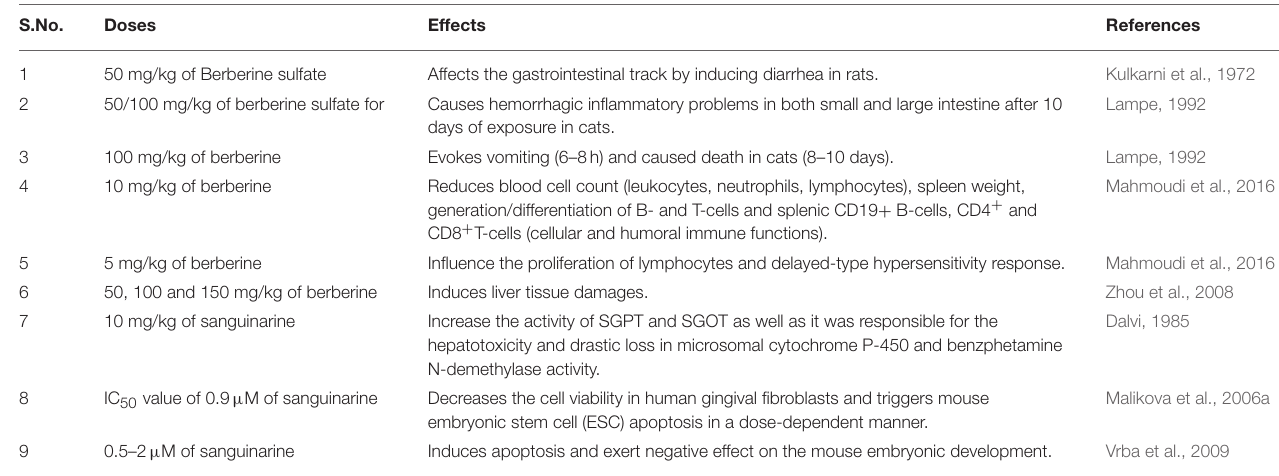
TABLE 2 | Dose dependent effects of berberine and